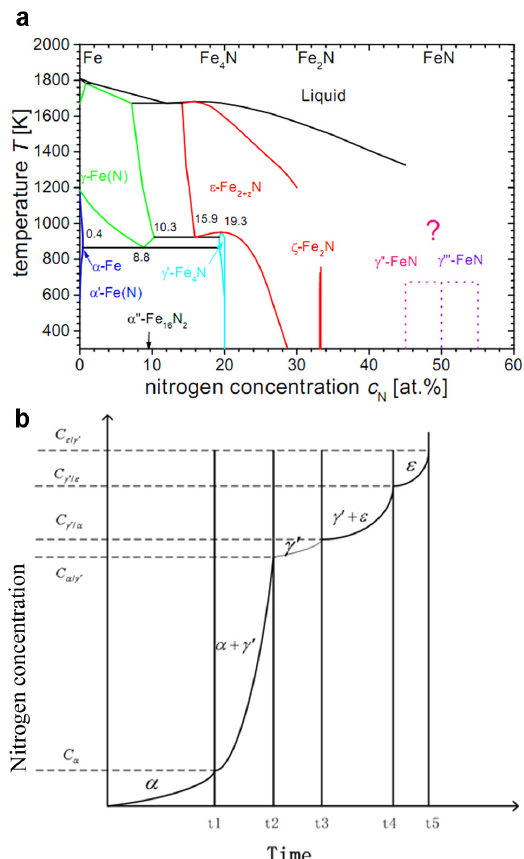
Fig. 1 a Fe-N phase diagram; b schematic illustration of Fe-N phases composition in the nitriding